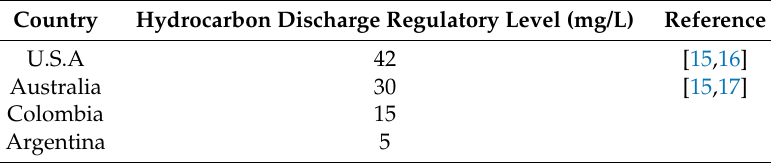
Table 2. Hydrocarbon discharge regulations in different